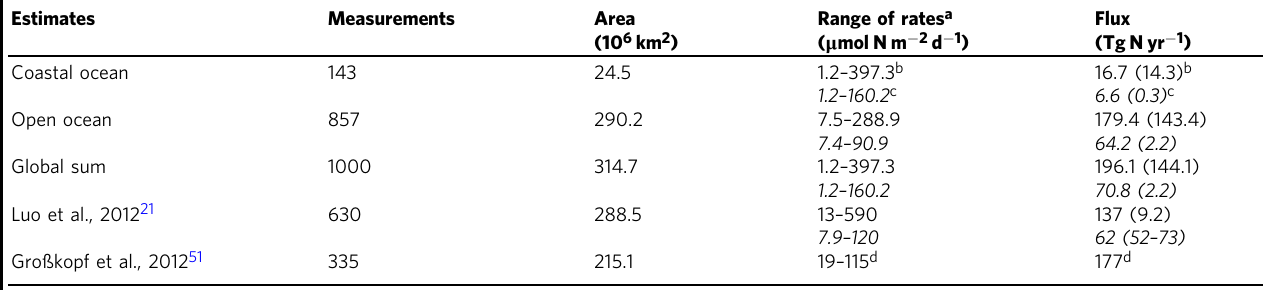
Table 1 N 2 fi xation rates in the open and coastal ocean compared with previous